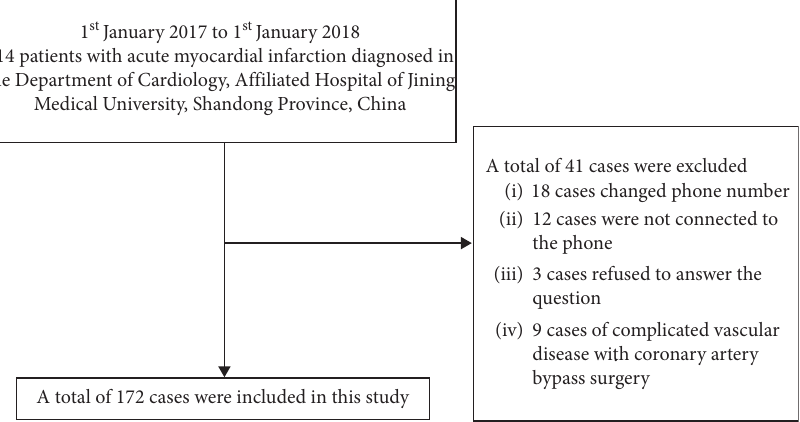
Figure 1: Inclusion/exclusion